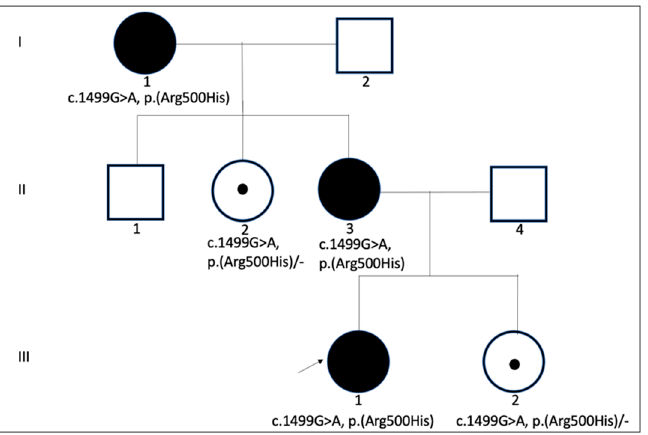
Figure 4. The three-generation family pedigree demonstrating segregation pattern of OPA1 c.1499G>A p.(Arg500His). Roman numerals indicate generations. The arrow indicates the case that underwent robotic surgery.